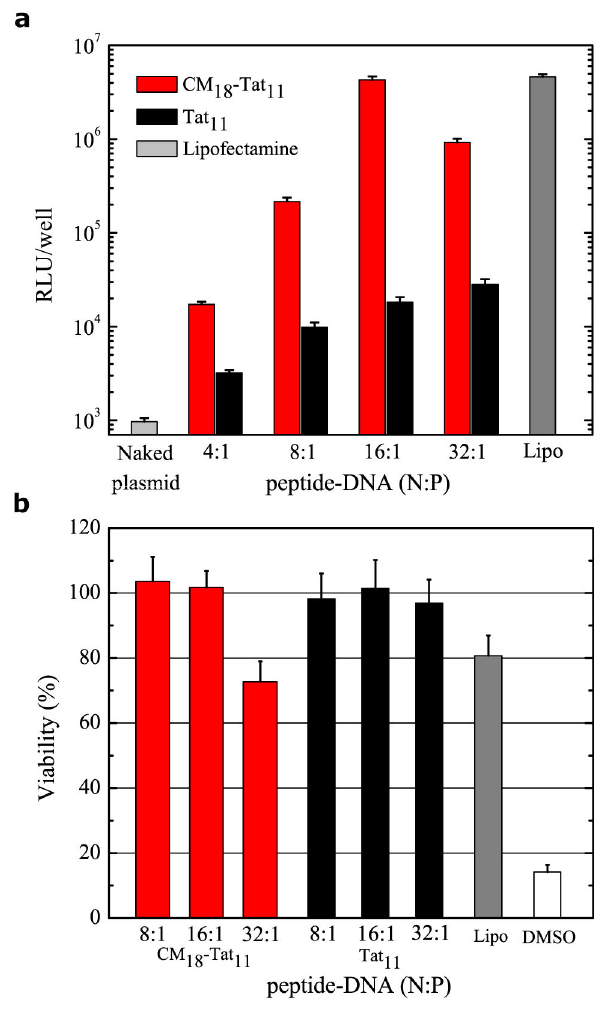
Figure 2. CM -Tat /DNA plasmid complex in vitro 18 11 transfection efficiency and cytotoxicity. ( a ) Transgene expression is detected 24 hours after transfection by measuring luciferase activity from an aliquot of the HeLa cells external medium. Light grey column is the mean value obtained with naked DNA, dark grey column is for lipofectamine, while red and black column are respectively for CM -Tat and Tat 18 11 11 DNA complex at N:P ratio from 4:1 to 32:1. The reported RLU/ well values represent the mean of three independent measurements, each performed in triplicate. ( b ) Wst-8 assay to evaluate cell metabolic activity. The wst-8 reagent was added for 2 hours and absorbance at 450 nm measured. Untreated cells are defined as 100% viable, while cells exposed to 20% dimethyl sulfoxide (white column) are used as positive control for decreased metabolic activity. doi: DNA, respectively. Please note that, while CM -Tat -atto633 18 11 signal slightly decreases during transfection (red line in Figure 3h), the DNA-Cy3 signal grows (green line). We believe that former effect can be ascribed to the progressive metabolic